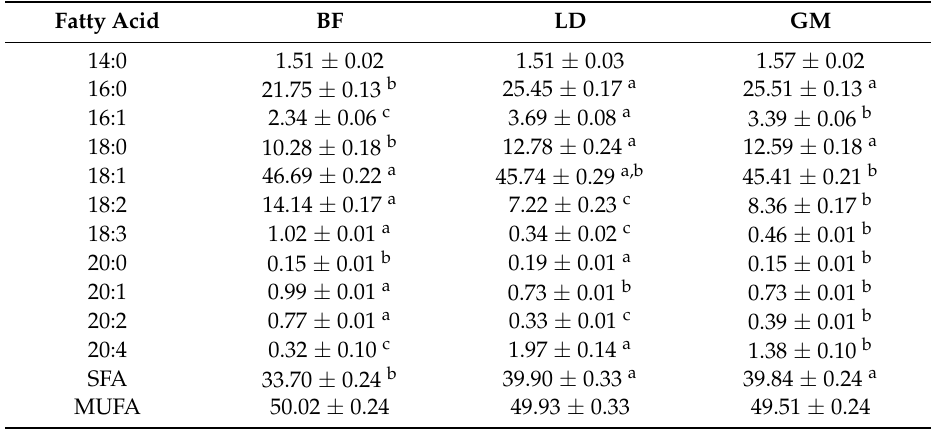
Table 1. Fatty acid composition (%, mean ± standard error) of backfat (BF), m. longissimus dorsi (LD) and m. gluteus medius (GM) in a purebred Duroc line 1